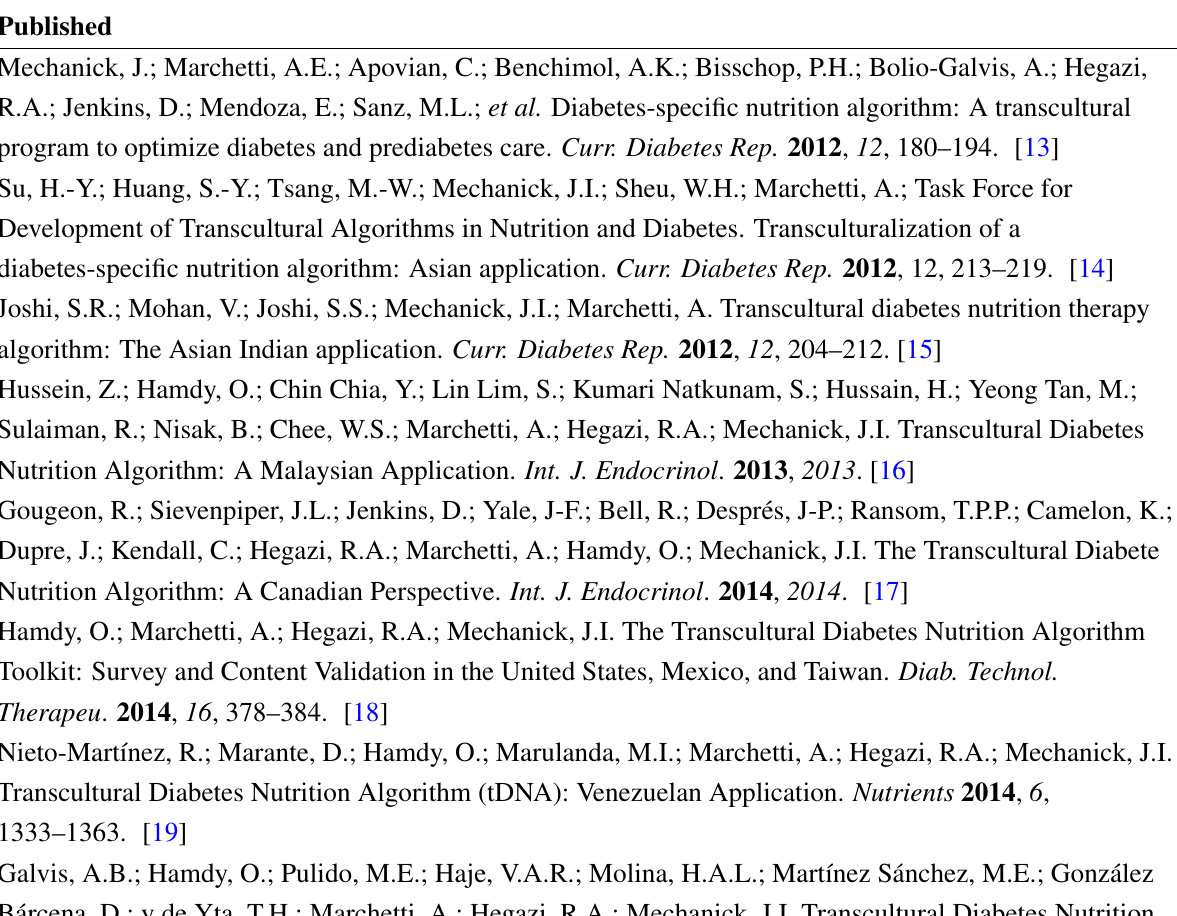
Table 1. Transcultural Nutrition Algorithm